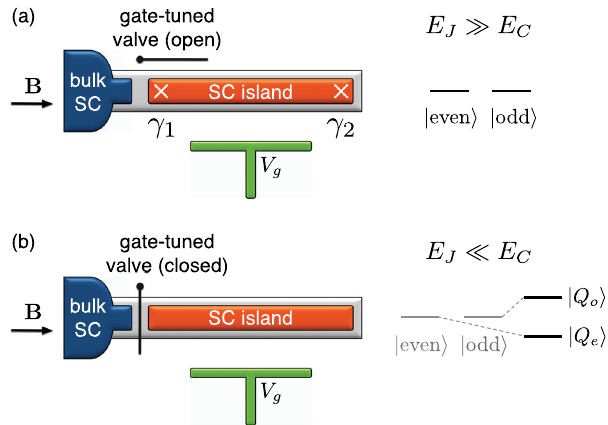
FIG. 1. Semiconducting wire coated with a superconducting island and bulk SC that are bridged by a gate-tunable “ valve. ” The valve controls the carrier density in the barrier region and thereby modulates the ratio of Josephson energy E to the island J charging energy E . In addition, a back gate at voltage V tunes C g ≫ E the charge on the island. (a) When the valve is open ( E ) J C an applied magnetic field B drives the wire into a topological superconducting state hosting Majorana zero modes γ 1 . The ; 2 system thus supports degenerate ground states with even and odd ≪ E fermion parity. (b) Closing the valve ( E ) restores charging J C energy and converts these parity eigenstates into nondegenerate states with island charges Q and Q , as shown on the right. o e The gate-controlled “ parity-to-charge conversion ” illustrated here is central to the manipulation and read out schemes developed in this